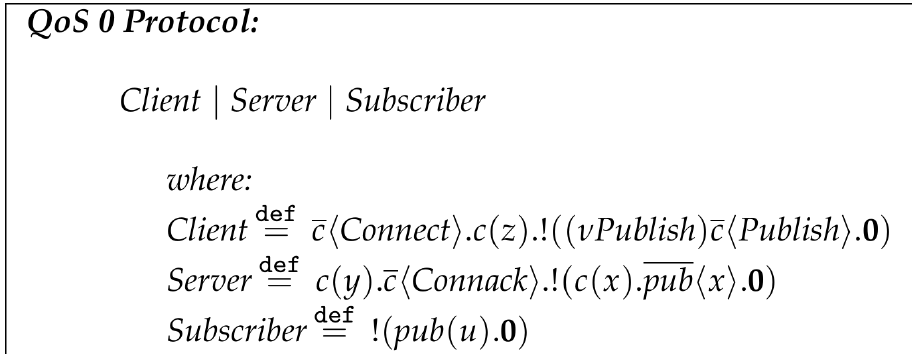
Figure 3. The MQTT QoS 0 protocol as modelled in the language of the π